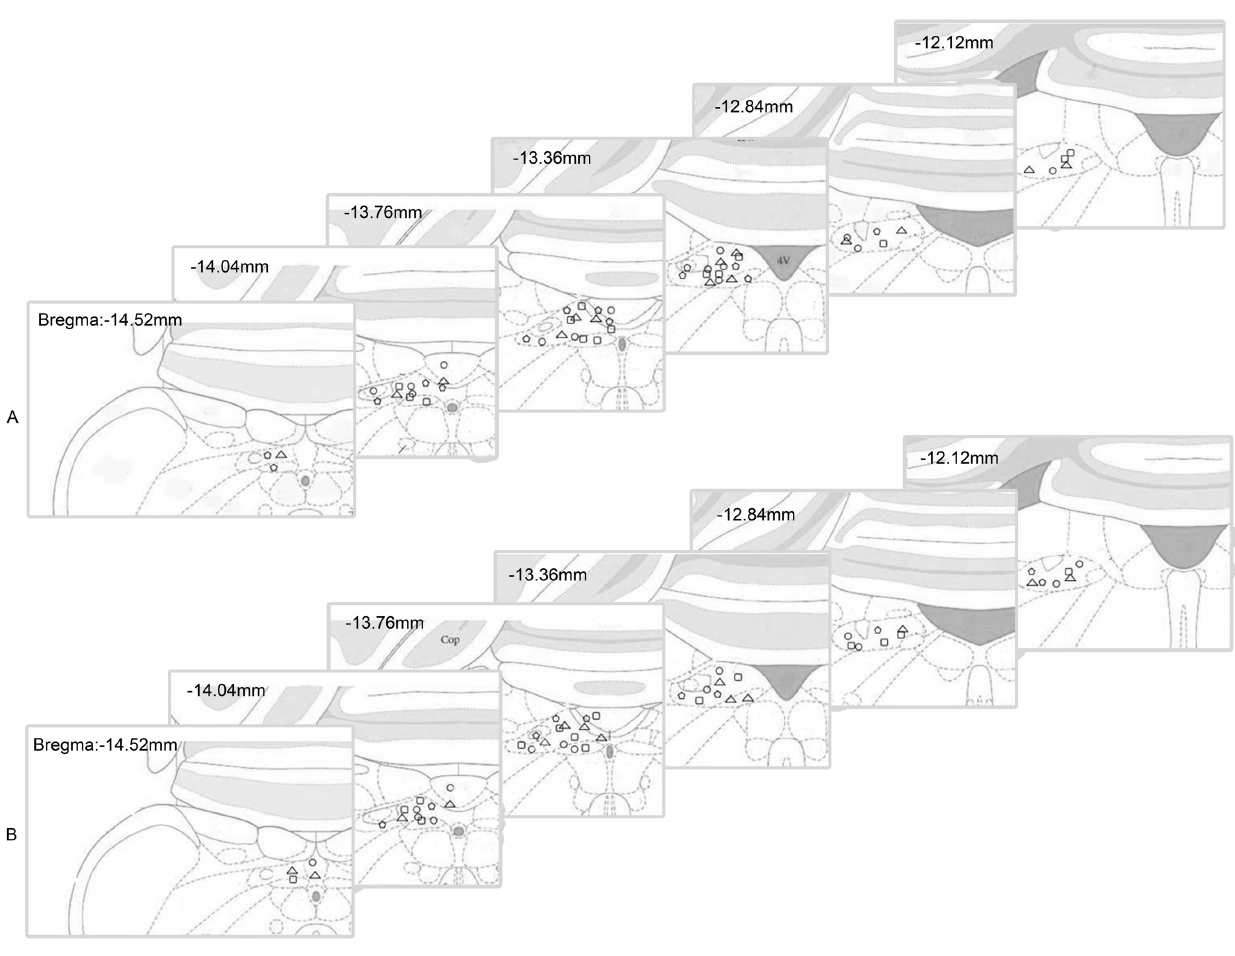
Figure 3. Maps of injection sites in DVC. A. Confirmation of injection sites in food intake measurement. Control (triangle, n=14), 15 pmol nesfatin-1 (circle, n=14), 25 pmol nesfatin-1 (square, n=14), 50 pmol nesfatin-1 (pentagon, n=14). B. Confirmation of injection sites in body weight gain measurement: control (triangle, n=14), 15 pmol nesfatin-1 (circle, n=14), 25 pmol nesfatin-1 (square, n=15), 50 pmol nesfatin-1 (pentagon,